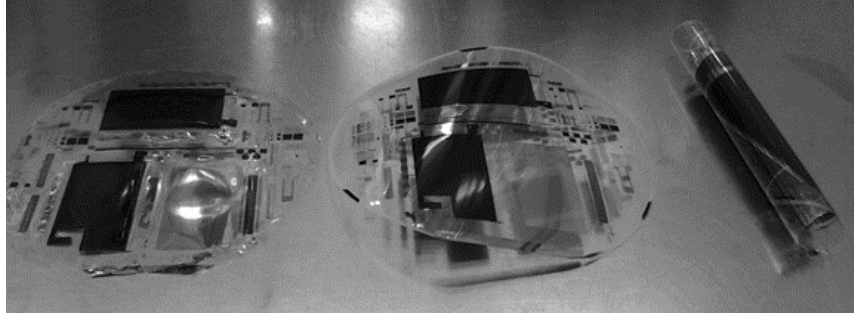
Figure 11. Curl comparison of low coefficient of thermal expansion (CTE) polyimide ( Left ), PEN ( Middle ), and high CTE polyimide ( Right ) debonded. PEN ( Middle ), and high CTE polyimide ( Right )